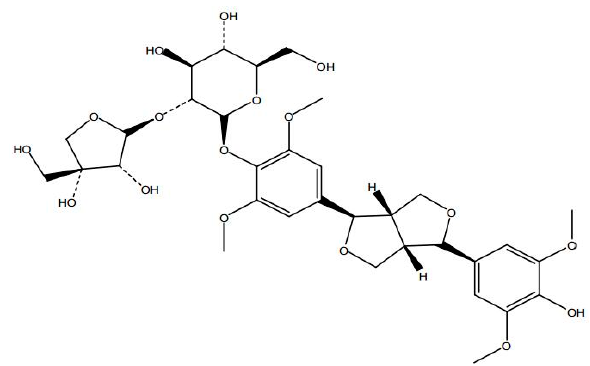
Figure 4. Structure of ( − )-syringaresnol-4- O - β - D -apiofuranosyl-(1 → 2)- β - D -glucopyranoside (SAG).